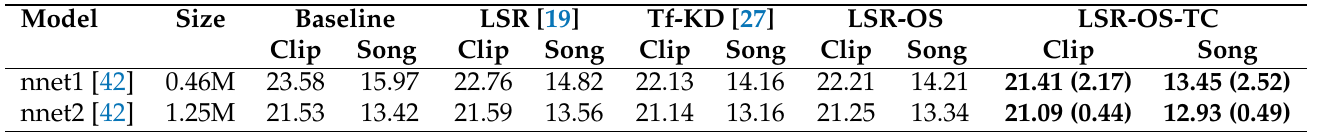
Table 4. Test set error rate comparison on the GTZAN dataset. The column head “Clip” indicates the 3-second fragment results and under “Song” is the averaged total excerpt